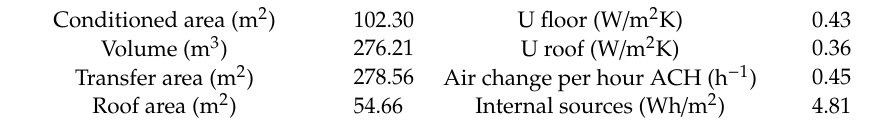
Table 3. Other main building parameters.